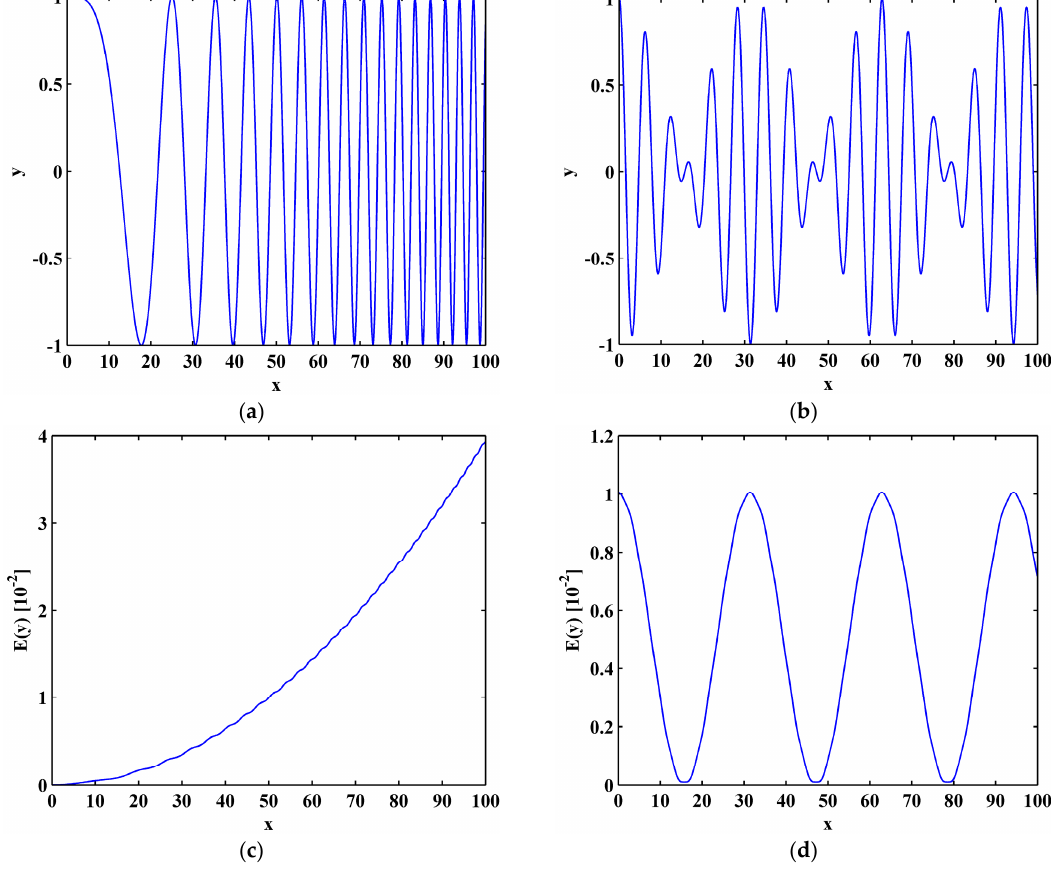
Figure 1. FM ( a ) and AM ( b ) signals; and their respective TKE ( c , d ).